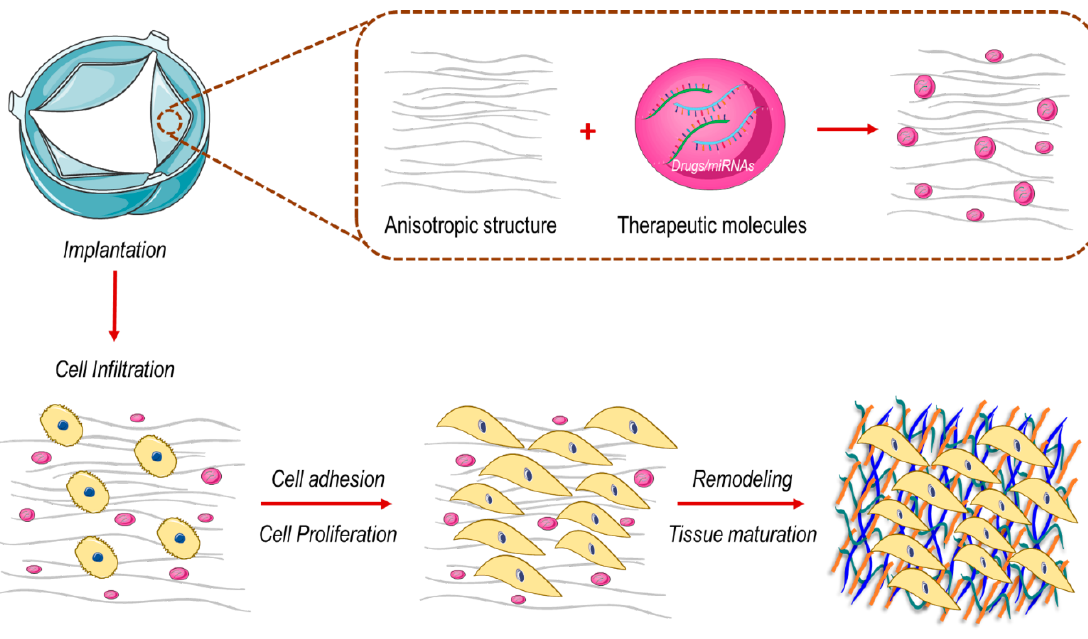
Figure 2. In situ tissue engineered heart valve (TEHV) approach. By the use of this approach, the wound healing cascade—which characterize valve regeneration process—is harnessed for repopulating cell-free synthetic sca ff old with living cells. A specific anisotropic structure of the sca ff old in combination with specific therapeutic molecules involved in cell mechanosensing (e.g., YAP inhibitors, drugs interfering with stress fibers tensioning) drive towards a sca ff old repopulation with proliferative non-activated cells able to synthetize new ECM components (collagen (blue), elastin (green) and GAG (orange)) and thus realize a functional heart valve tissue.